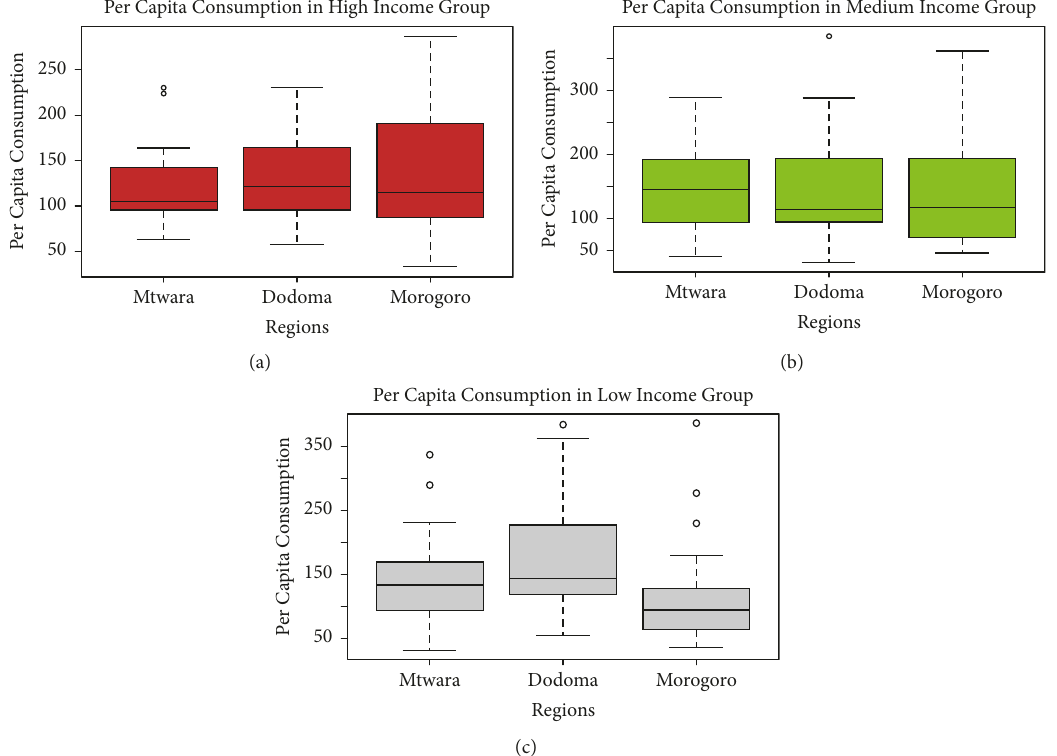
Figure 7: Per capita charcoal consumption ( y -axis in kg per year) in (a) high-income, (b) medium-income, and (c) low-income groups in the three regions ( x